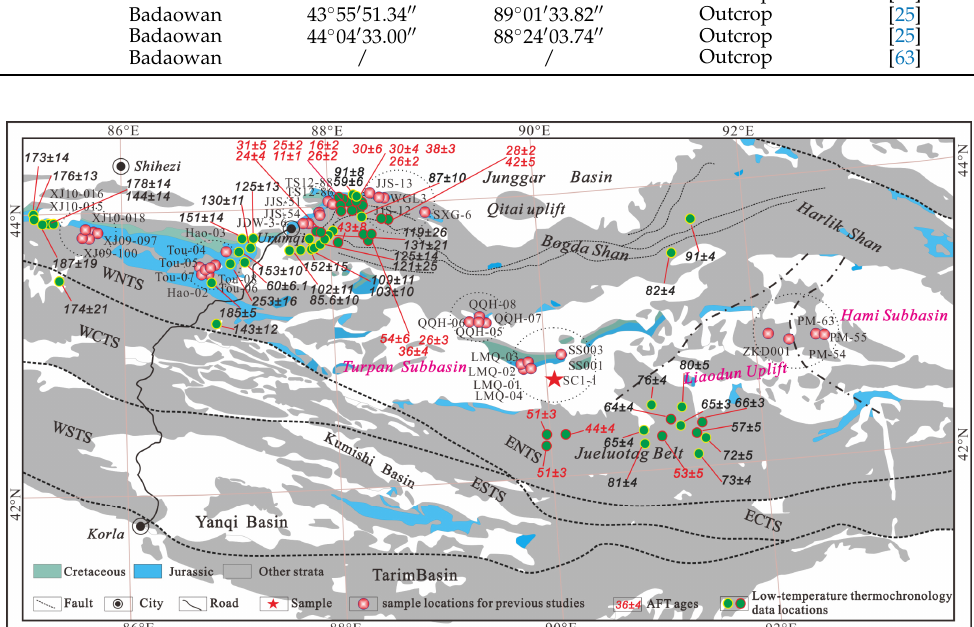
basin (Table 1). The position details of Well SC1 are shown in Figures 1c and 3.